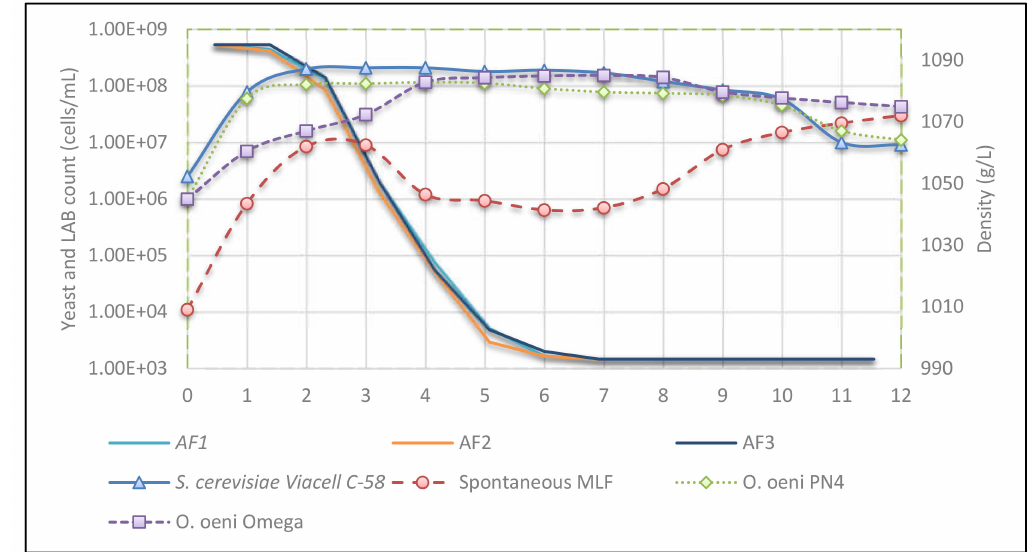
Figure 1. Progress of the yeast Viacell C-58 ® ( ∆ ) and lactic acid bacteria population (dashed lines) and must density (continuous lines) during the three wine alcoholic fermentations denoted as (AF1, AF2, and AF3) and performed with Tempranillo musts using the following inoculation strategies: no lactic acid bacteria (LAB) inoculation ( • ); inoculation with LAB PN4 TM ( (cid:7) ); and inoculation with LAB Omega TM ( (cid:4) ). Data represented correspond to mean values obtained from duplicate fermentations; in all cases standard deviation was < 1.5. MLF means malolactic